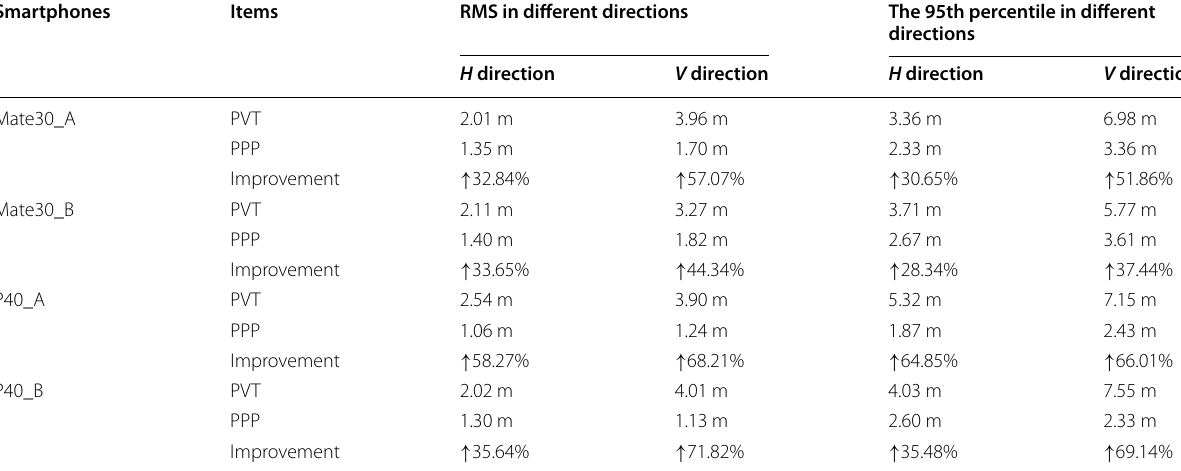
Table 7 Statistics of the positioning accuracy of PPP and PVT results in the dashboard mode